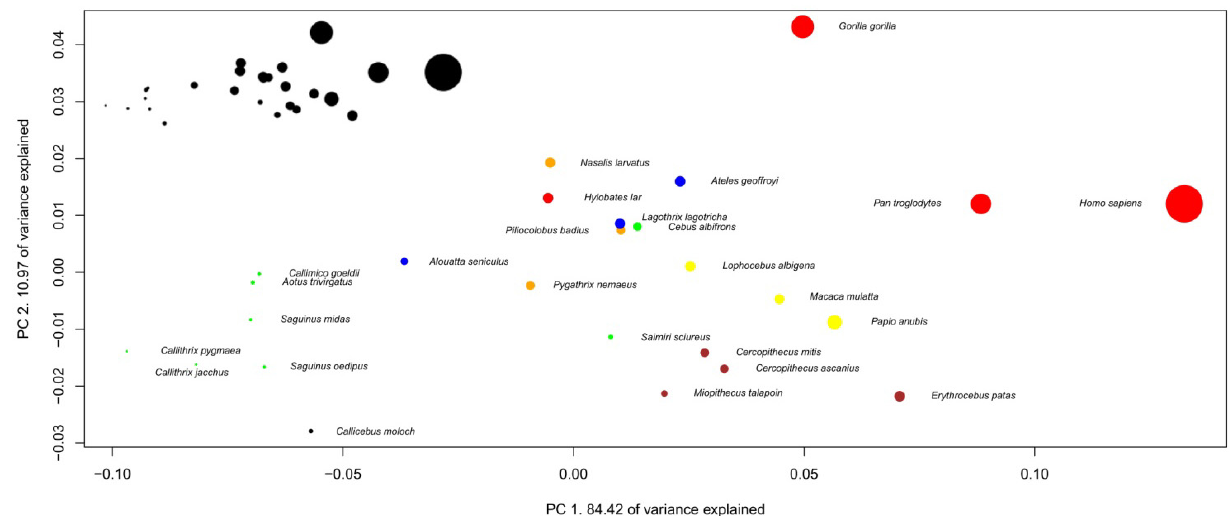
Figure 5. Phylogenetic Principal Component Analysis of simians’ brain structure proportions. Regression on independent contrasts of logged absolute brain size onto independent contrasts of position on PC1: Multiple R -squared: 0.706, F -statistic: 57.72 on 1 and 24 DF, P = 7.771 × 10 − 8 ; PC2: Multiple R -squared: 0.132, F -statistic: 3.655 on 1 and 24 DF, P = 0.0679. Families are: black: Pitheciidae, red: Hominoidea, green: Cebidae, blue: Atelidae, brown: Cercopithecini, orange: Colobinae, yellow: Papionini.